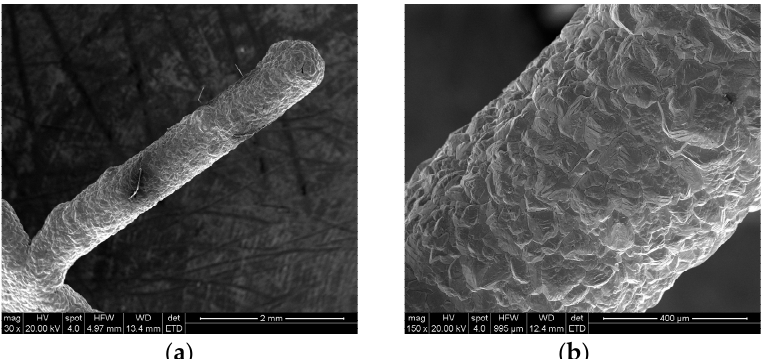
Figure 9. SEM examples after copper electroforming: ( a ) integral topography, ( b ) local topography.